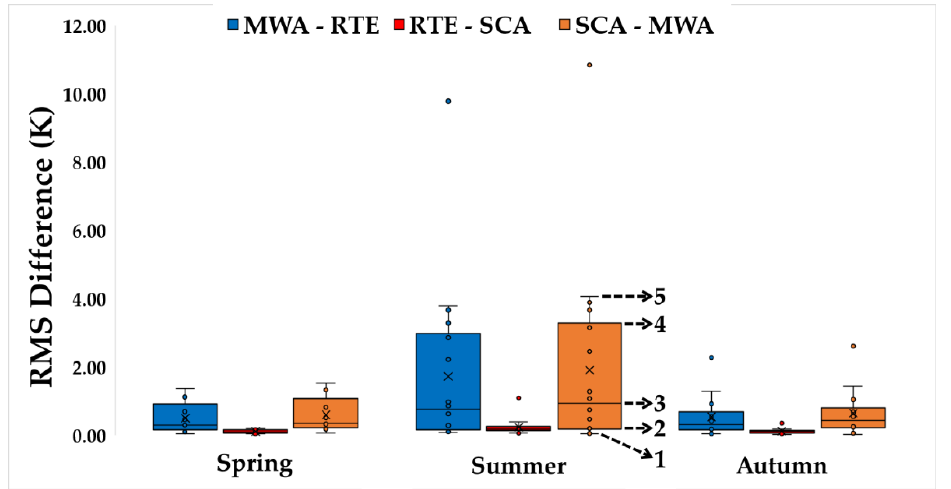
Figure 3. Seasonal RMS differences between the LST retrieval methods. Box-plot information: minimum (1), first quartile (2), median (3), third quartile (4), and maximum (5). The cross “x” in the boxes is the mean value of the data set.